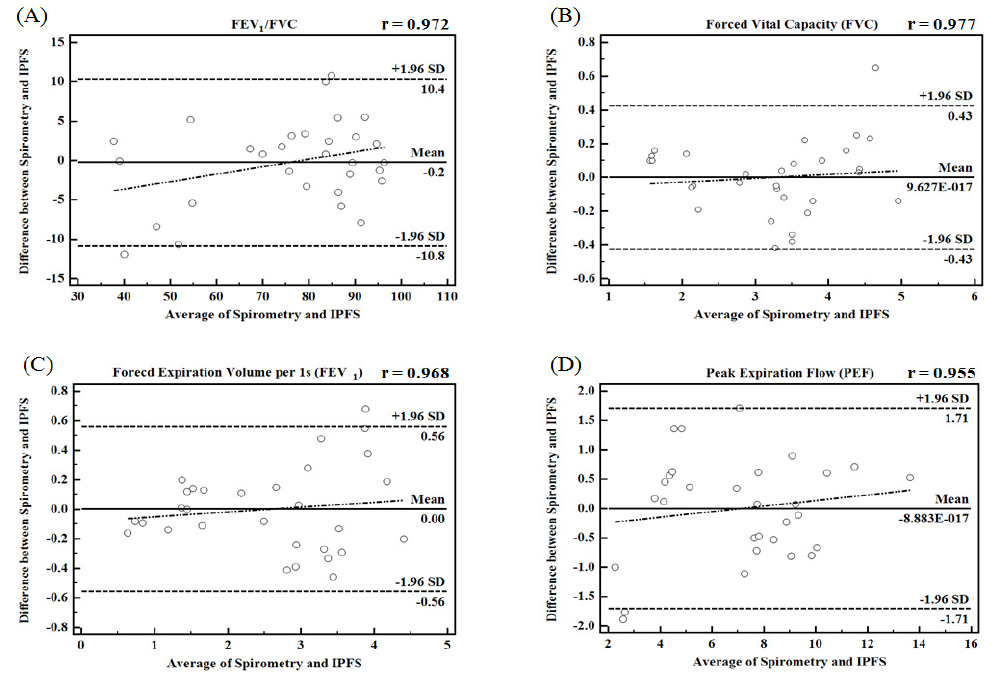
IPFS and spirometry. The PFT indices are FVC, FEV , and FEV % for the volume and PEF for the 1 1 w signal. PFT indices obtained using spirometry (x-axis) were well correlated with those obtained axis) when analyzed for all subjects ( p < 0 . 05 Figure 5. Bland–Altman plots about PFT indices between IPFS and spirometry;